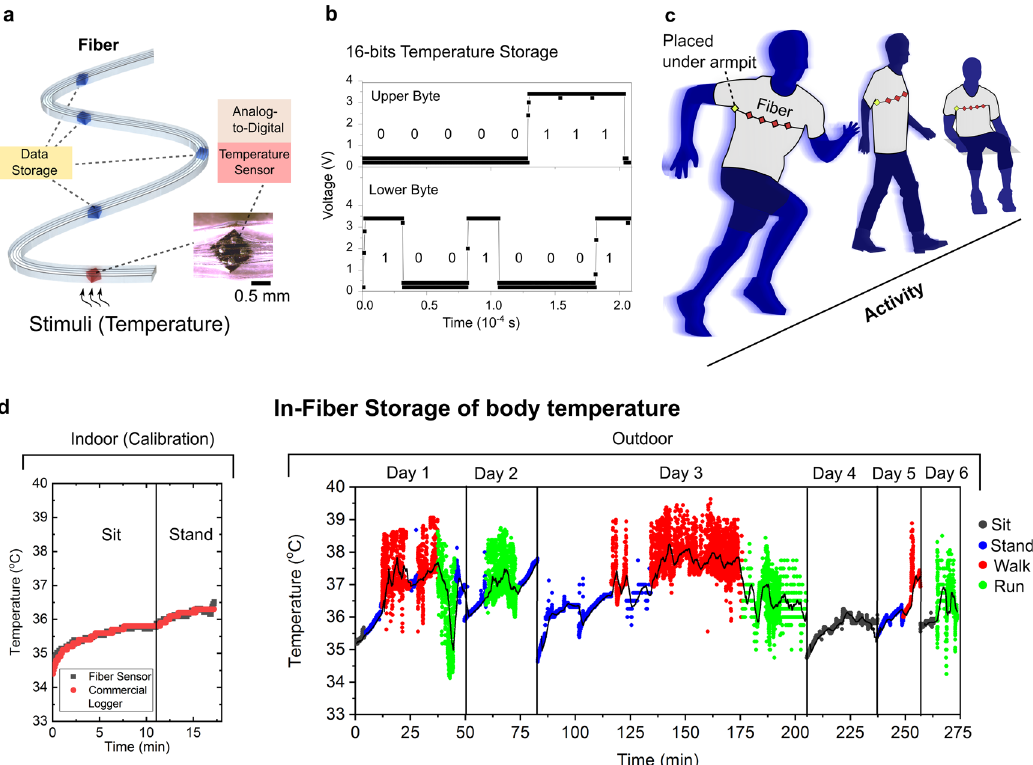
Fig. 4 Hybrid digital fi bres for physiological monitoring. a Schematic of a hybrid digital memory and temperature-sensing (MT) fi bre, containing a single thermistor device with multiple interconnected memory units along the fi bre length. Upon temperature sensing, the analogue signal is converted to digital locally by the thermistor. The digital signals are processed by an external processor and transmitted to the in- fi bre memory units for data storage. b Voltage – time plot of a 16-bit temperature measurement segmented into an upper and lower byte. The reading shown corresponds to a value of 1937, which is then converted to the decimal form of 19.37 during data analysis. c Schematic showing implementation of the MT fi bre into a compression shirt that is worn by the user for storage of body temperature across different activities. Note that the thermistor unit is placed under the armpit to measure axillary body temperature. d Time plots of the in-fabric stored values of the user ’ s body temperature. (left) The MT fabric temperature readings were calibrated with and validated against a commercial temperature logger and shown to correspond to reference measurements. (right) In-fabric storage of body temperature across 4.5 h (split up into multiple days) and across different activities. Uniquely, the MT fabric allows for outdoor activities, unlike conventional, bulky temperature-measurement equipment. Moreover, the MT fi bre is fl exible, permitting temperature recording across dynamic activities such as walking and running. The black line is the moving average over a 2-minute window. The lower temperature recorded during running is attributed to sweat cooling of the